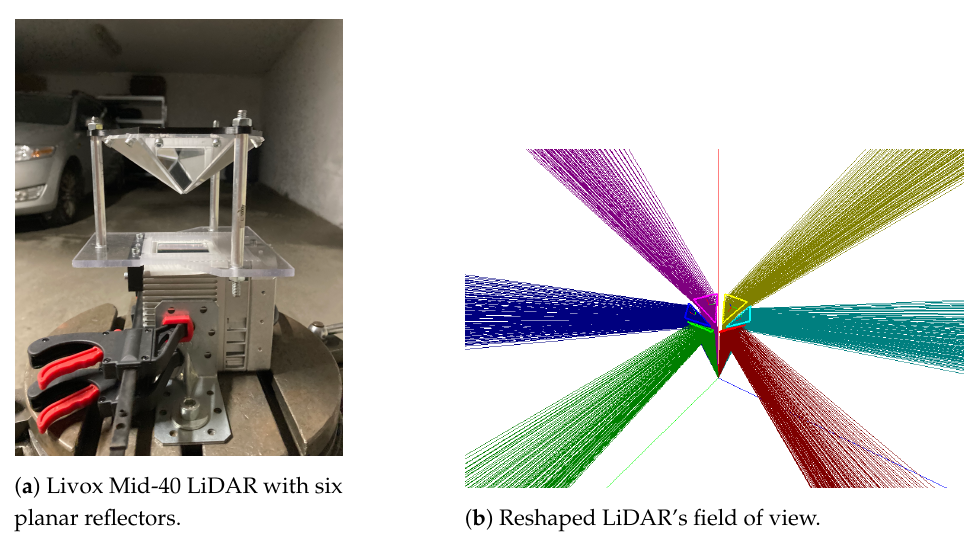
Figure 1. Prototype of LiDAR with planar